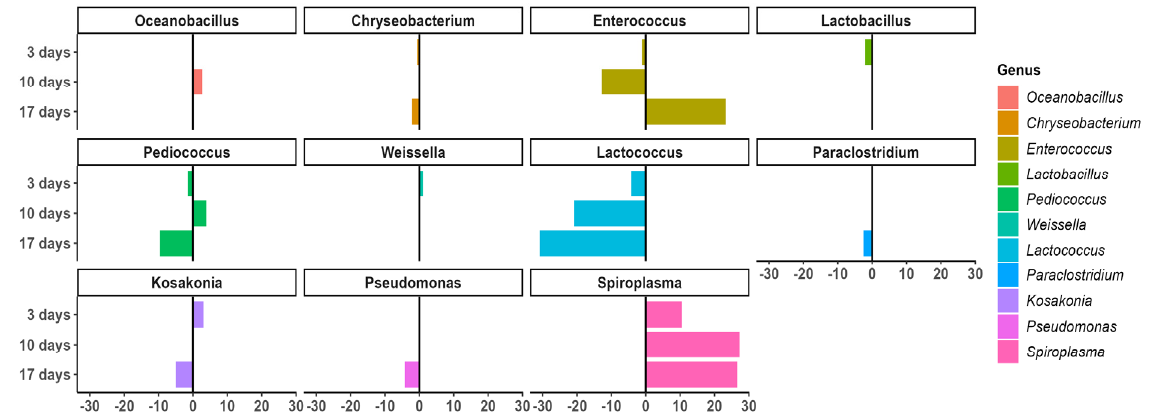
Figure 8. The levels and the differential abundance analysis of gut microorganisms for both diets.